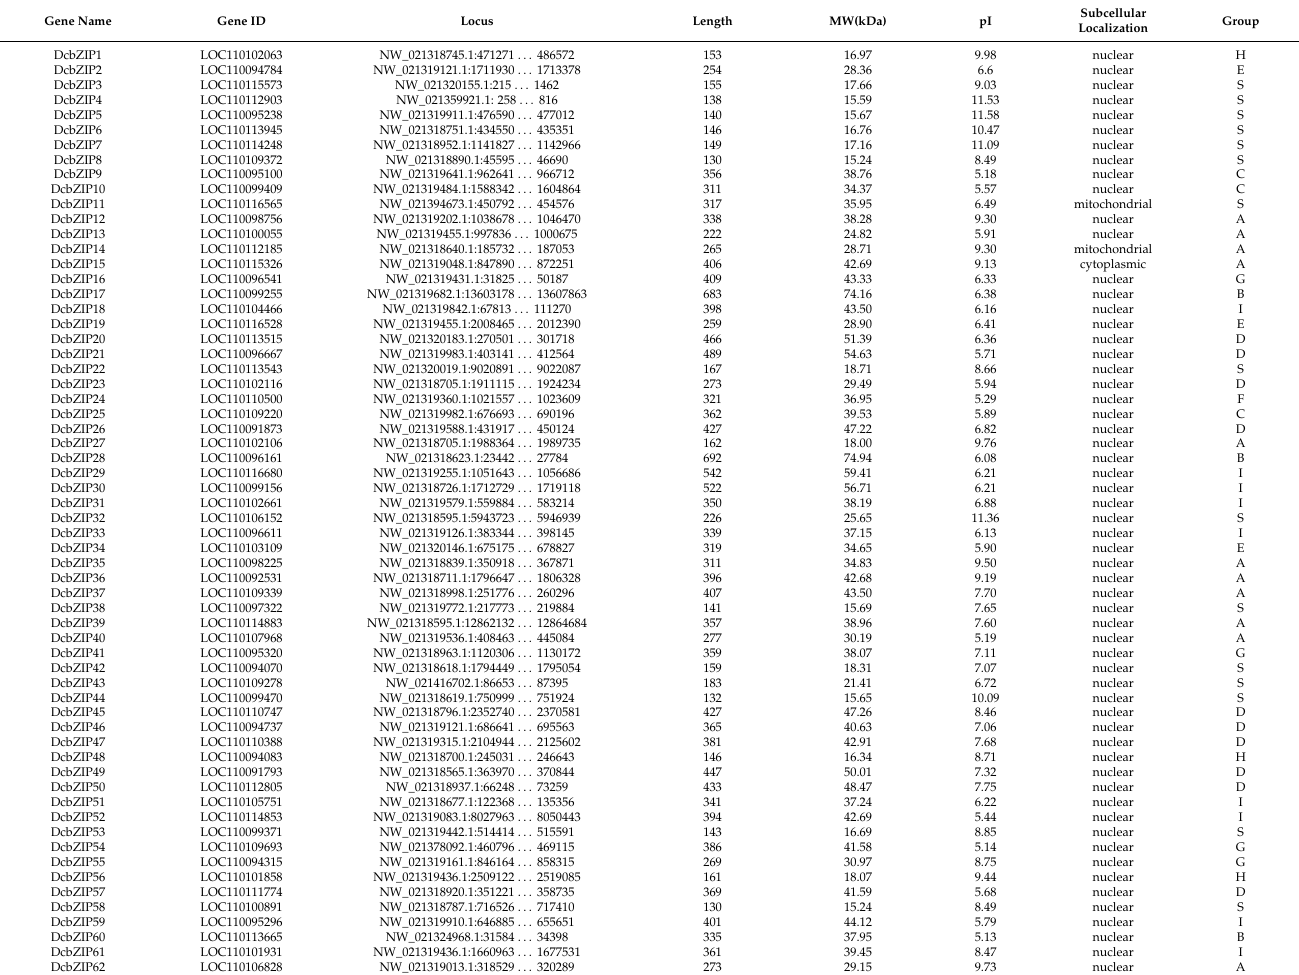
Table 1. Physicochemical properties of D. catenatum bZIP